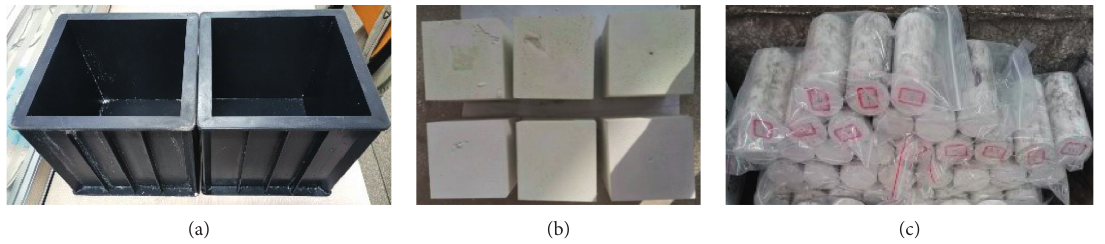
Figure 1: Remodeled samples of high-strength gypsum powder. (a) Casting mold. (b) Cube samples. (c) Standard